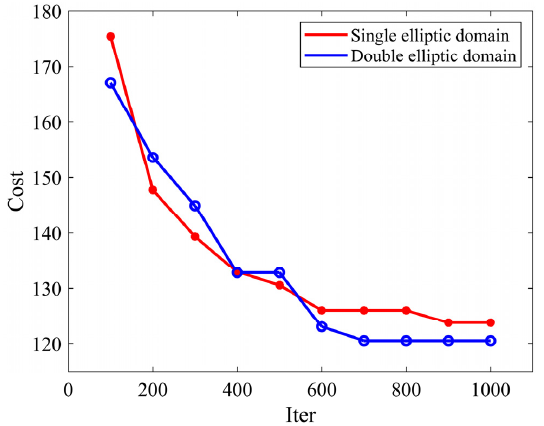
Figure 10. Comparison of the convergence of two elliptic sampling domains in scenario 2.